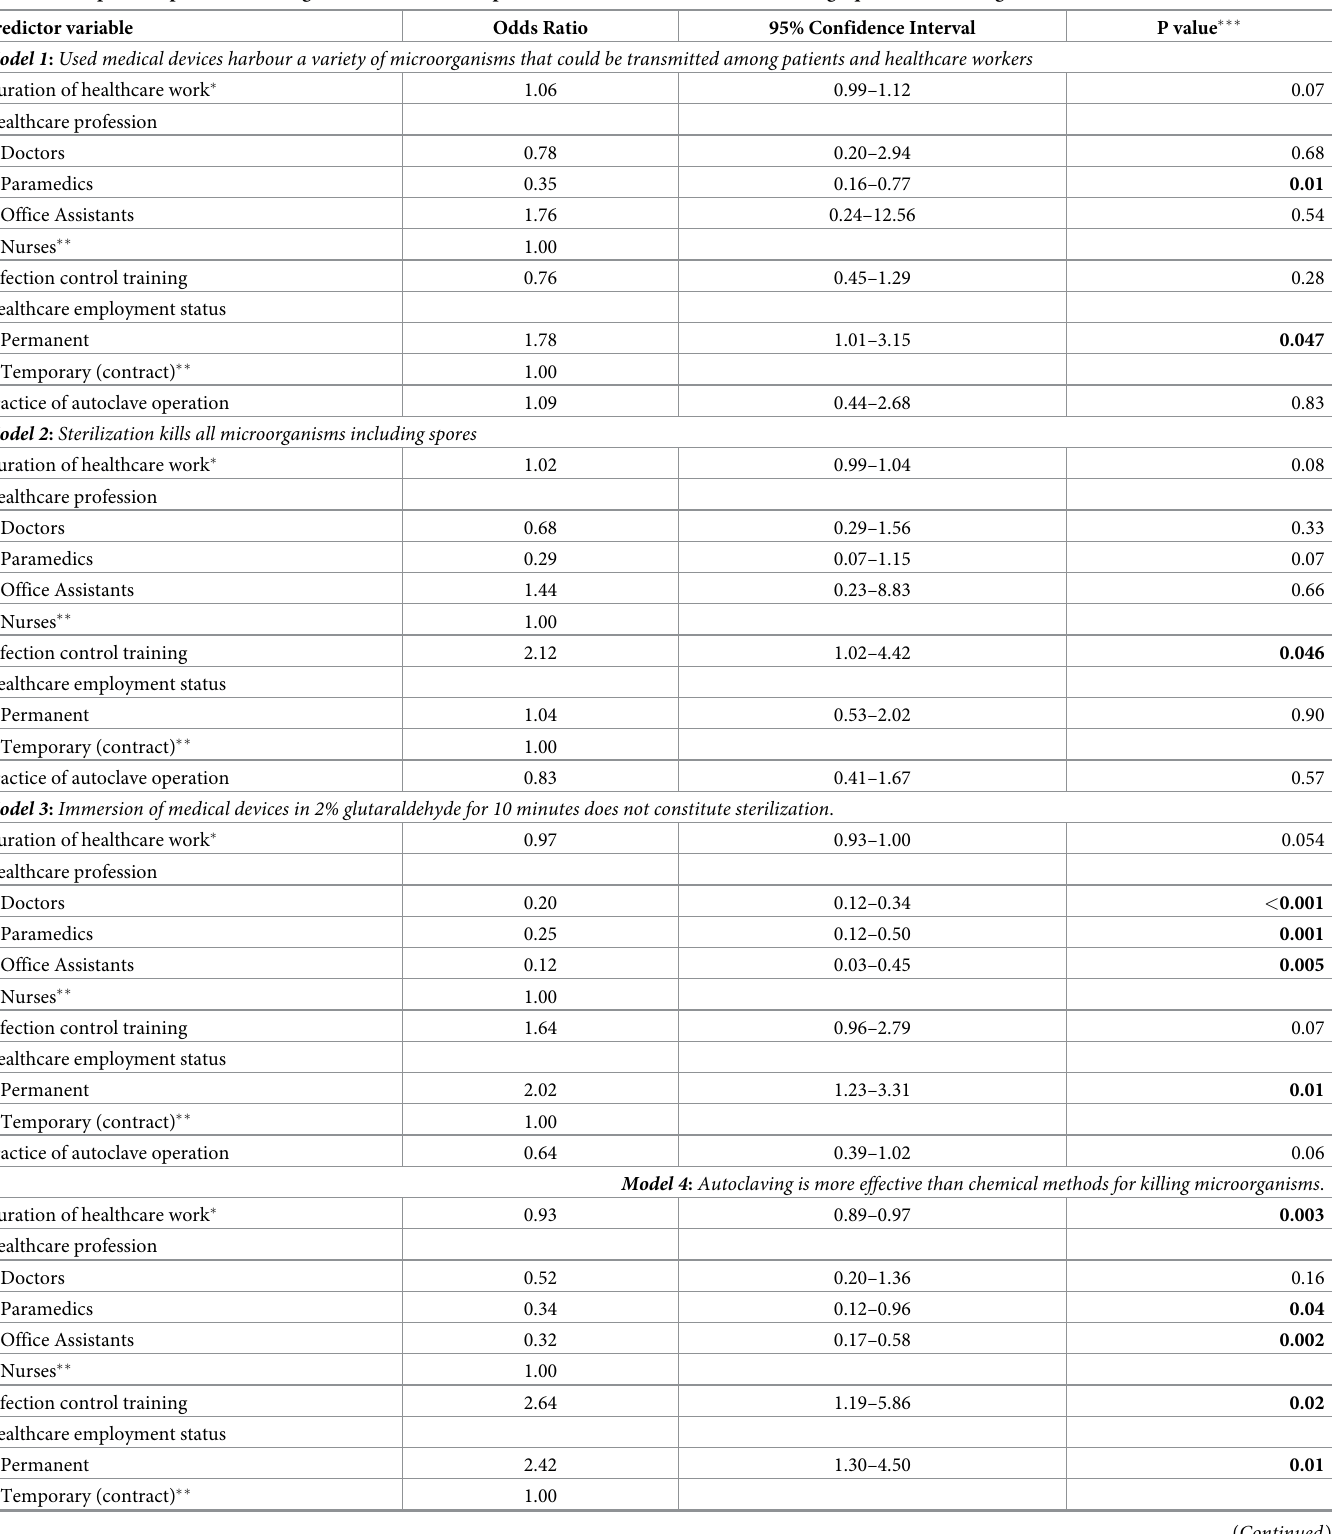
Table 3. Complex samples—ordinal regression models for responses of healthcare workers to knowledge questions in rating-scale